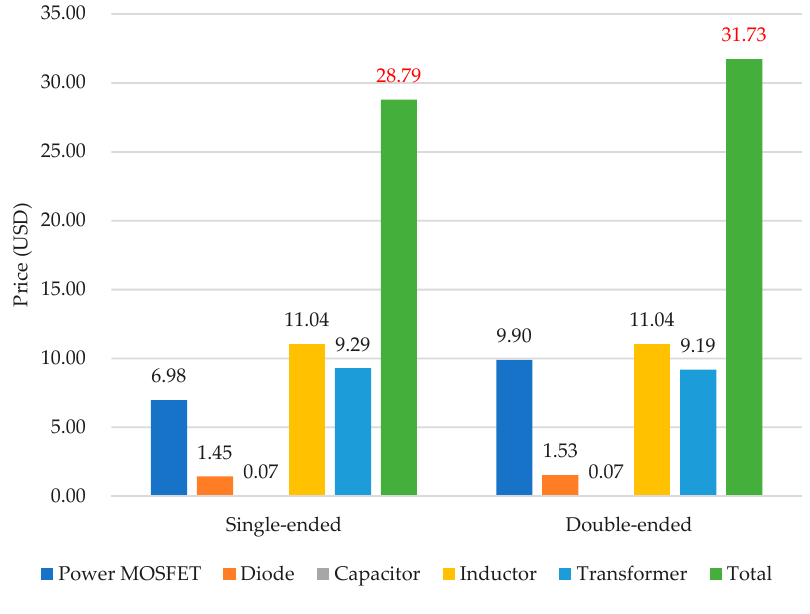
Figure 13. Cost comparison of forward converters.